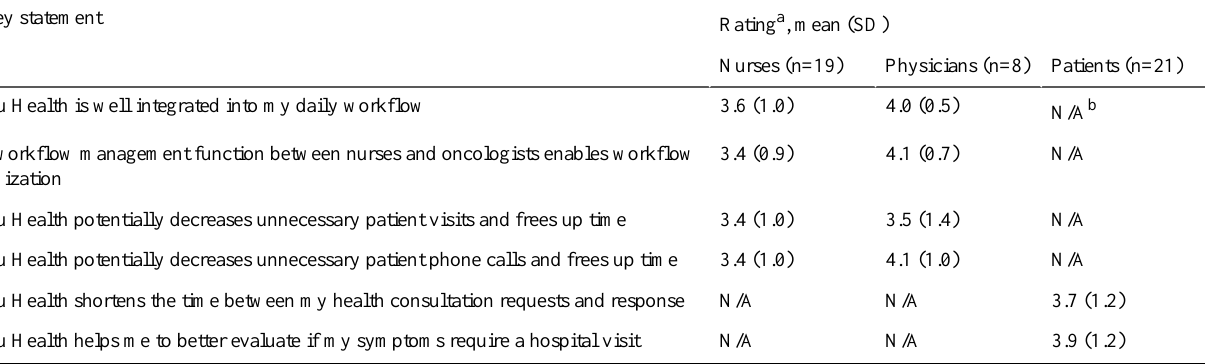
Table 4. Effect of the digital patient monitoring and management tool on efficiency for end-of-study survey respondents: general